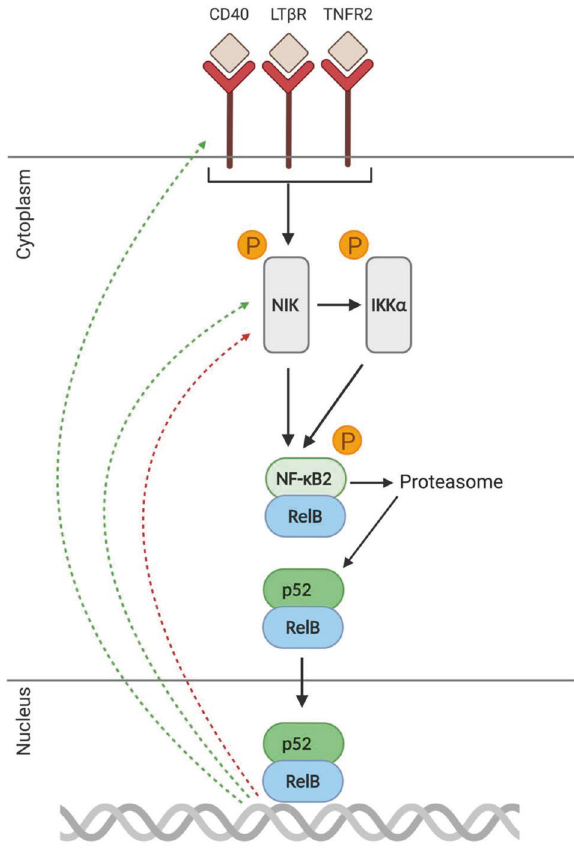
Fig. 4 Regulators of non-canonical NF- κ B activation. Cell-surface immunoreceptors activate NIK, which recruits IKK α to phosphorylate NF- κ B2. NF- κ B2 is then partially degraded by the proteasome into p52. As a result of NF- κ B2 processing into p52, the p52-ReB dimer moves into the nucleus where it initiates pro-in fl ammatory gene transcription. As such, NIK is considered the central regulator of the non-canonical pathway. Red dotted arrow indicates negative feed- back via NIK transcription, green dotted arrows indicate positive feedback via receptor and NIK